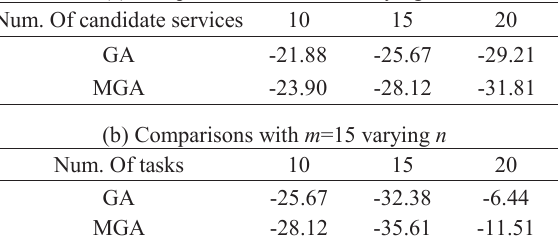
Fig. 4 indicates that MGA outperforms GA